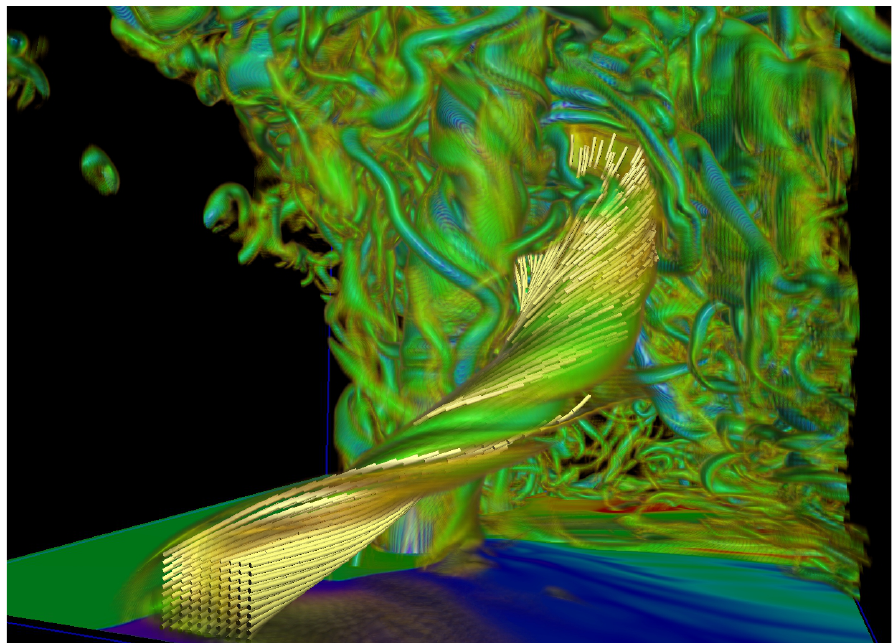
Figure 5. VAPOR Version 2 volume rendering of the 3D vorticity field and air trajectories